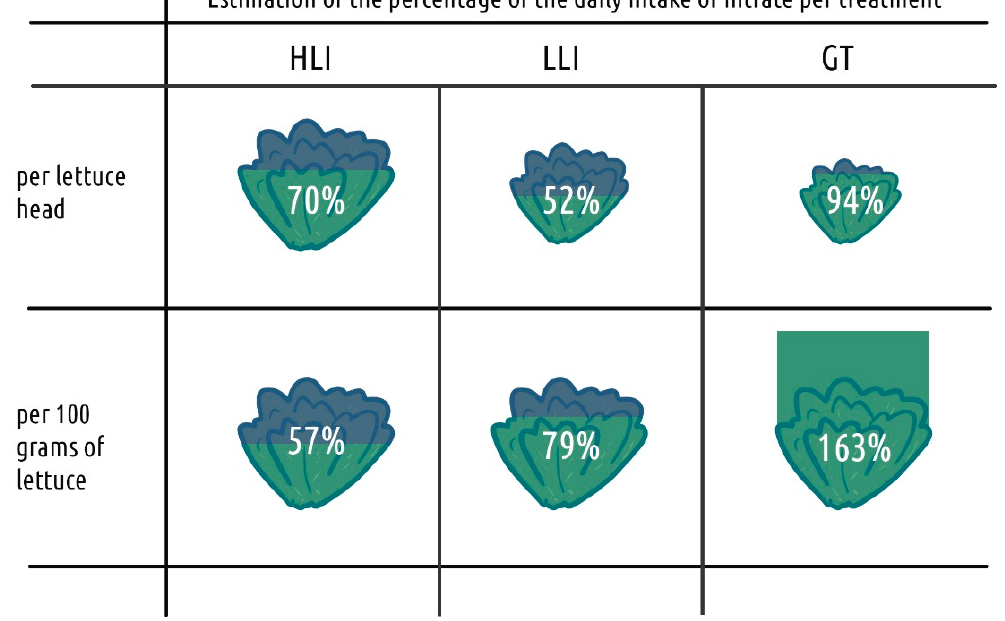
Figure 7. Estimation of percentage of the daily intake of nitrate of each treatment per average lettuce head and per 100 g of fresh produce. HLI, High light intensity; LLI, Low light intensity; GT, Glasshouse treatment.